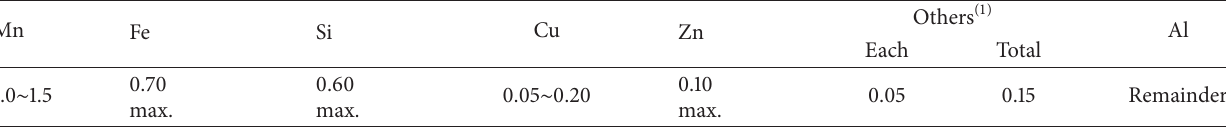
Table 1: Chemical composition of aluminium alloy 3003 (wt %).